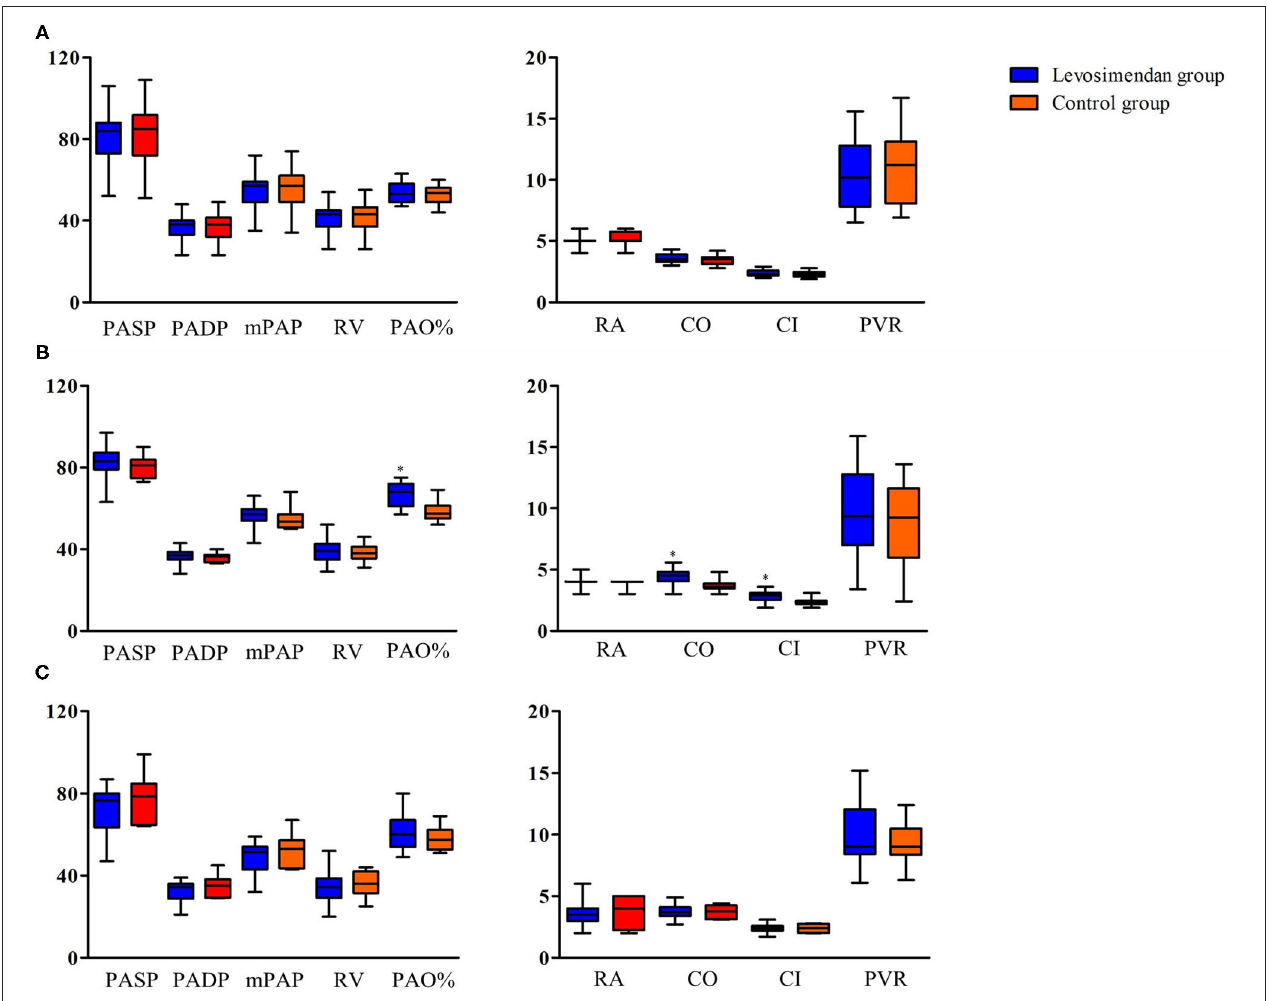
FIGURE 2 | Invasive hemodynamic measurements in patients with right heart catheterization. (A) On admission. (B) After drug treatment and symptom relief. (C) In the first 6 months after discharge. PASP, pulmonary artery systolic pressure; PADP, pulmonary artery diastolic pressure; mPAP, mean pulmonary artery pressure; RA, right atrial mean pressure; RV, right ventricular mean pressure; PAO, pulmonary arterial oxygen saturation; CO, cardiac output; CI, cardiac index; PVR, pulmonary vascular resistance; * P < 0.05 between levosimendan and control